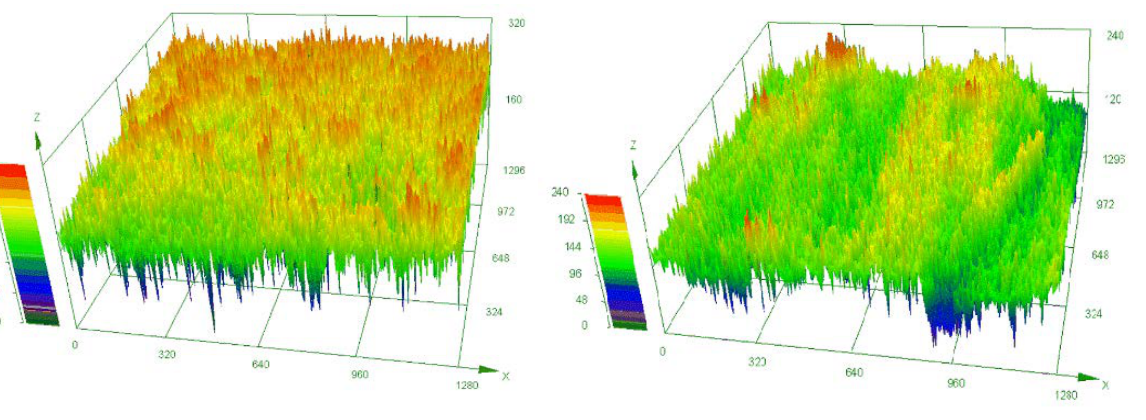
Figure 4. Relationship between MDR and SE for different materials.